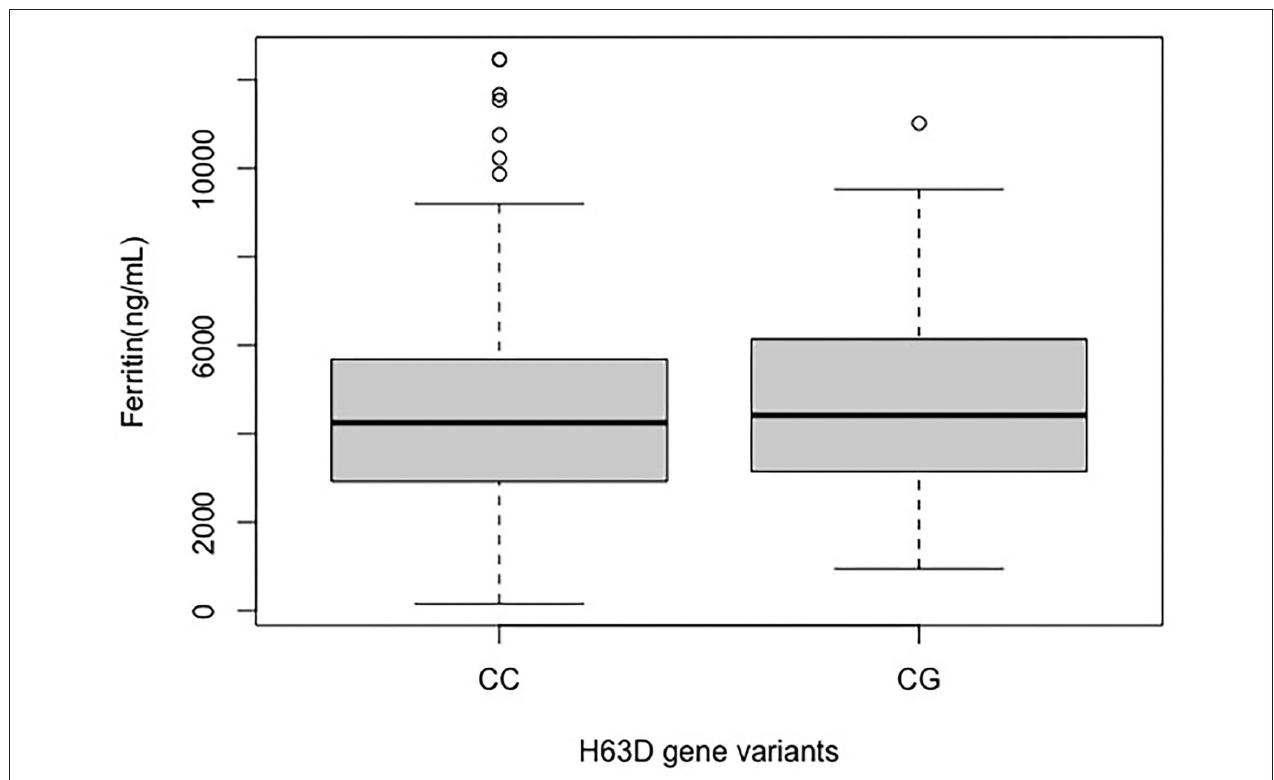
FIGURE 3 | Distribution of serum mean ferritin in H63D wild-type allele (CC) and H63D variant allele (CG) groups.